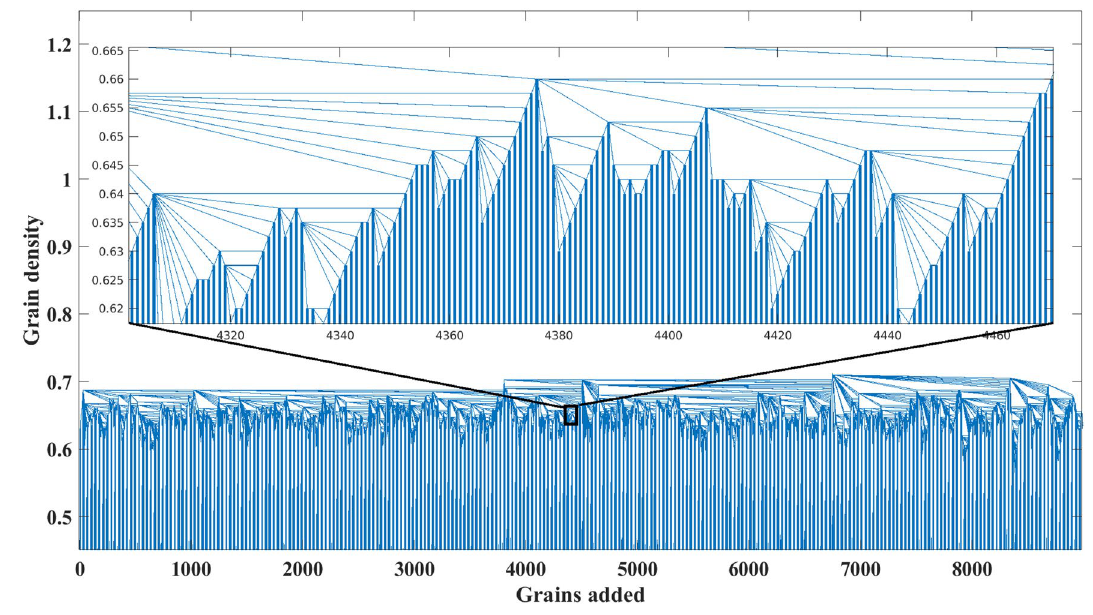
Figure 1. The HVG for the Manna sand-pile model with 9000